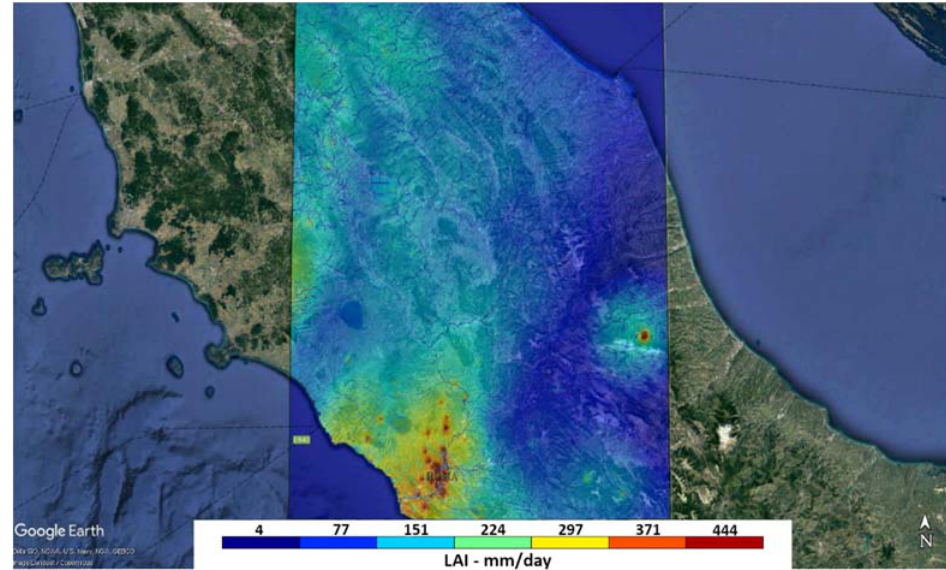
Figure 9. LAI index daily map for 31 January 2014.